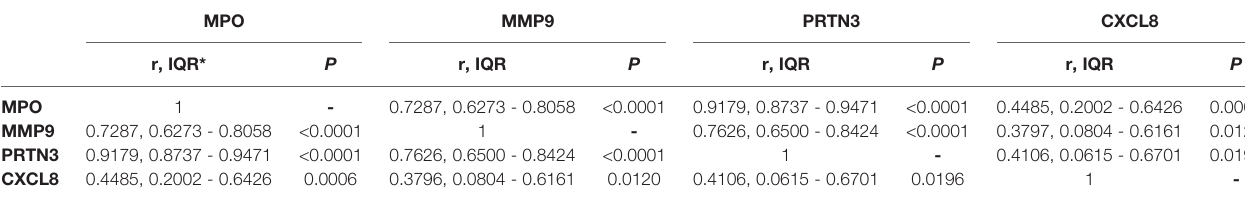
*Data represent results of Spearman ’ s test with IQR, interquartile